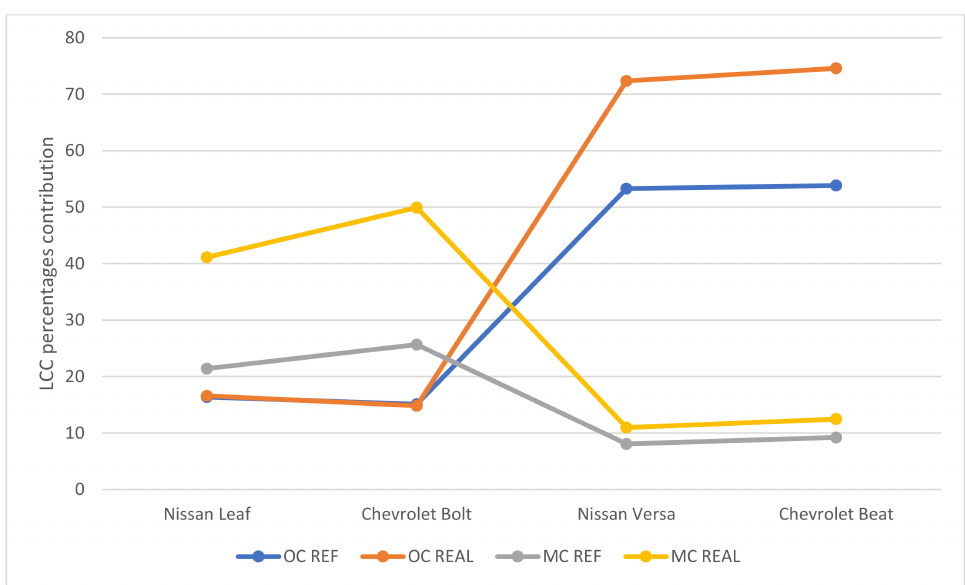
Figure 3. LCC percentage contributions of the operation cost and maintenance cost with the real distance vs. the reference distance.